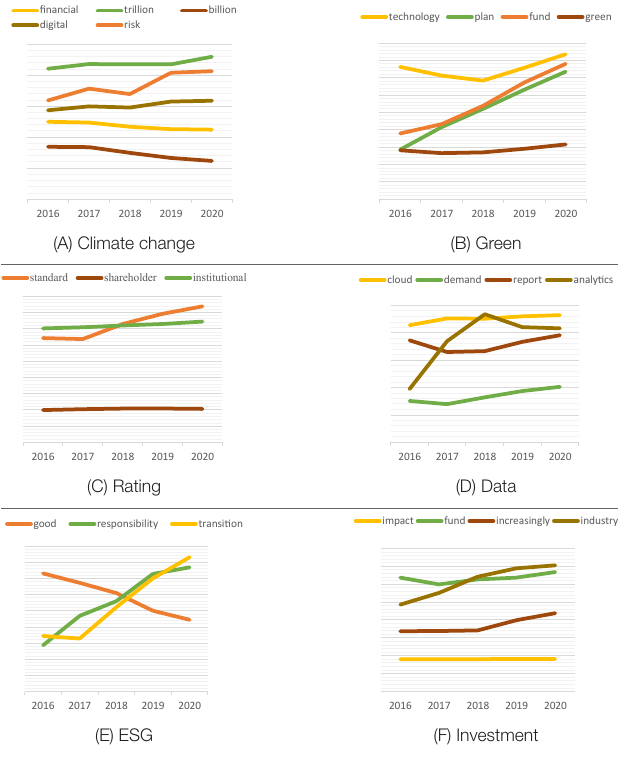
TABLE 3 | Time series transition of probability of selected words in the